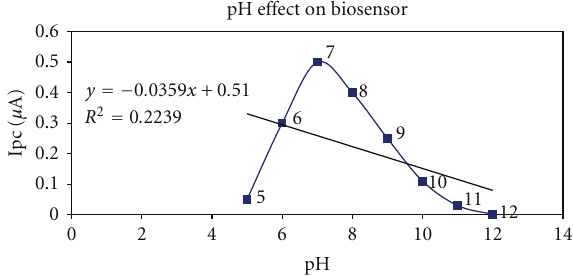
Figure 7: Dependence of the current response of Hb/Mn 2 O 3 -Ag nanofibers/GC electrode to 50.0 μ M H 2 O 2 on the pH of bu ff er solu-